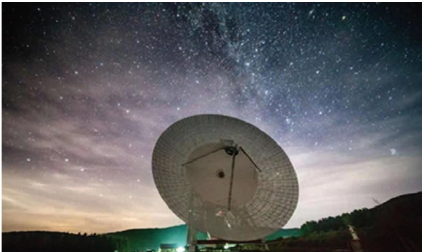
Figure 3: Jiamusi deep space station (https://www.smoc.ac.cn/ research/2318.jhtml).